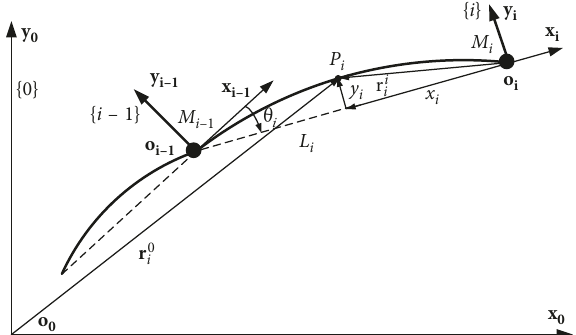
Figure 1: Deformation of link i represented in the float frame i and inertial reference frame 0